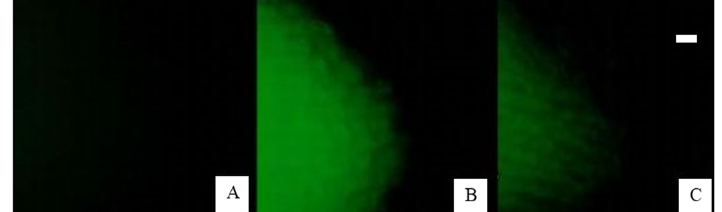
Figure 2. Border cell inhibition of aluminum uptake into the root cap detected by lumogallion staining. ( A ) Control roots incubated for 30 min at pH 5.2, in the absence of Al reveal no fluorescence; ( B ) Intense staining occurs in root tips whose border cells were dispersed prior to immersion of the root into 200 μ M Al for 30 min; ( C ) Reduced uptake of aluminum into root tips whose border cells were present on the root cap periphery at the time the roots were immersed into 200 μ M Al for 30 min [22]. Scale bar: 30 microns.